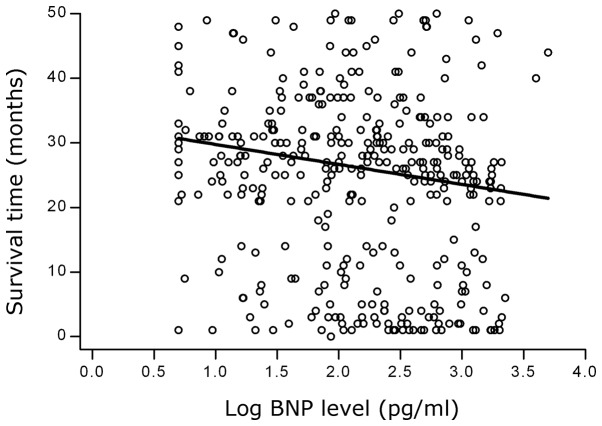
Scatter plot showing the correlation between the logBNP levels and the survival times in the HF patients with RLVSF. BNP, brain natriuretic peptide; HF, heart failure; RLVSF, reserved left ventricular systolic function.